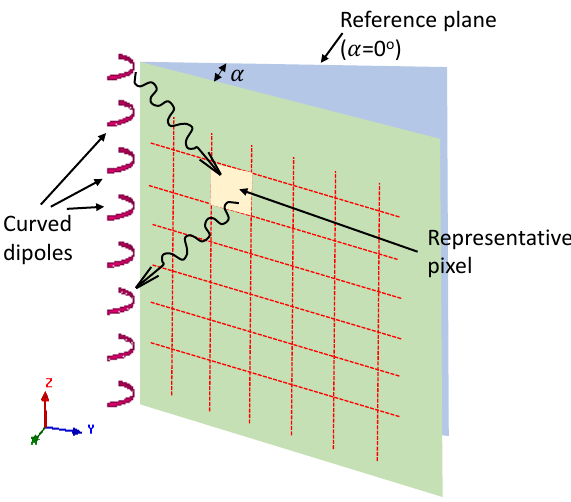
Figure 2. Imaging carried out on ϕ = α ( 0 ◦ ≤ α < 360 ◦ ) planes.